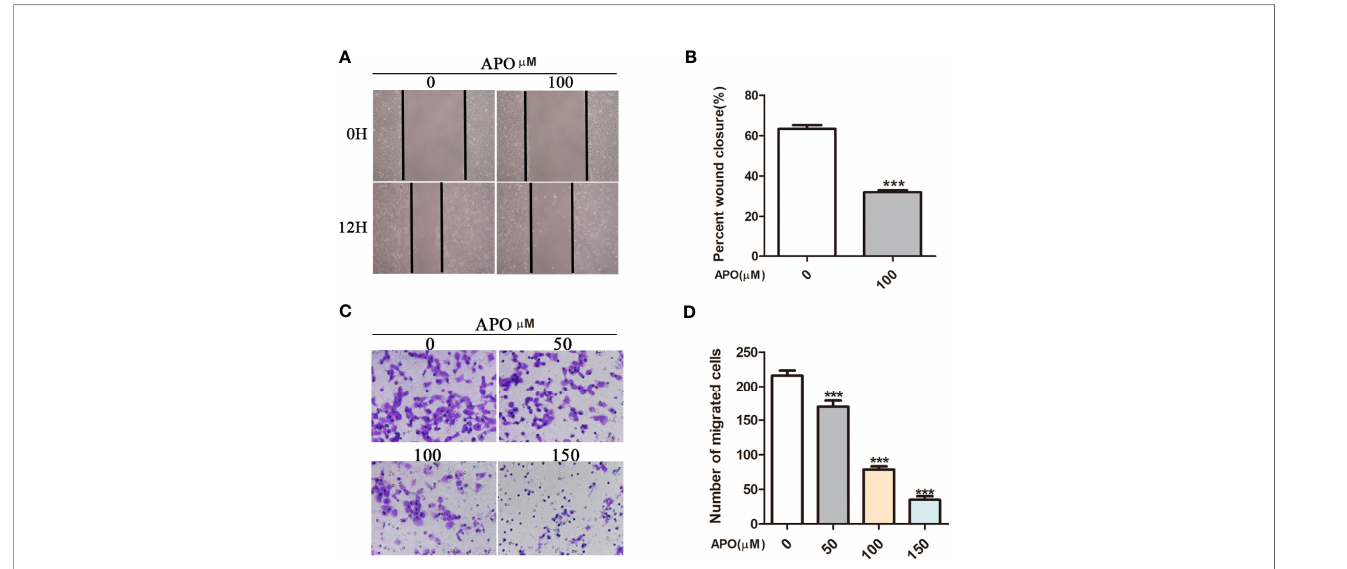
FIGURE 6 | APO inhibits OSCC cell migration and invasion in vitro. Migration assessed by in vitro wound-healing assay (A, B) quanti fi cation of EdU assay. Means ± SEM; *** P < 0.001; Student t-test analysis. Invasion assessed and by in vitro Transwell assay (8- m m pore size) (C, D) quanti fi cation of EdU assay. Means ± SEM; *** P < 0.001; two-way ANOVA analysis; APO,